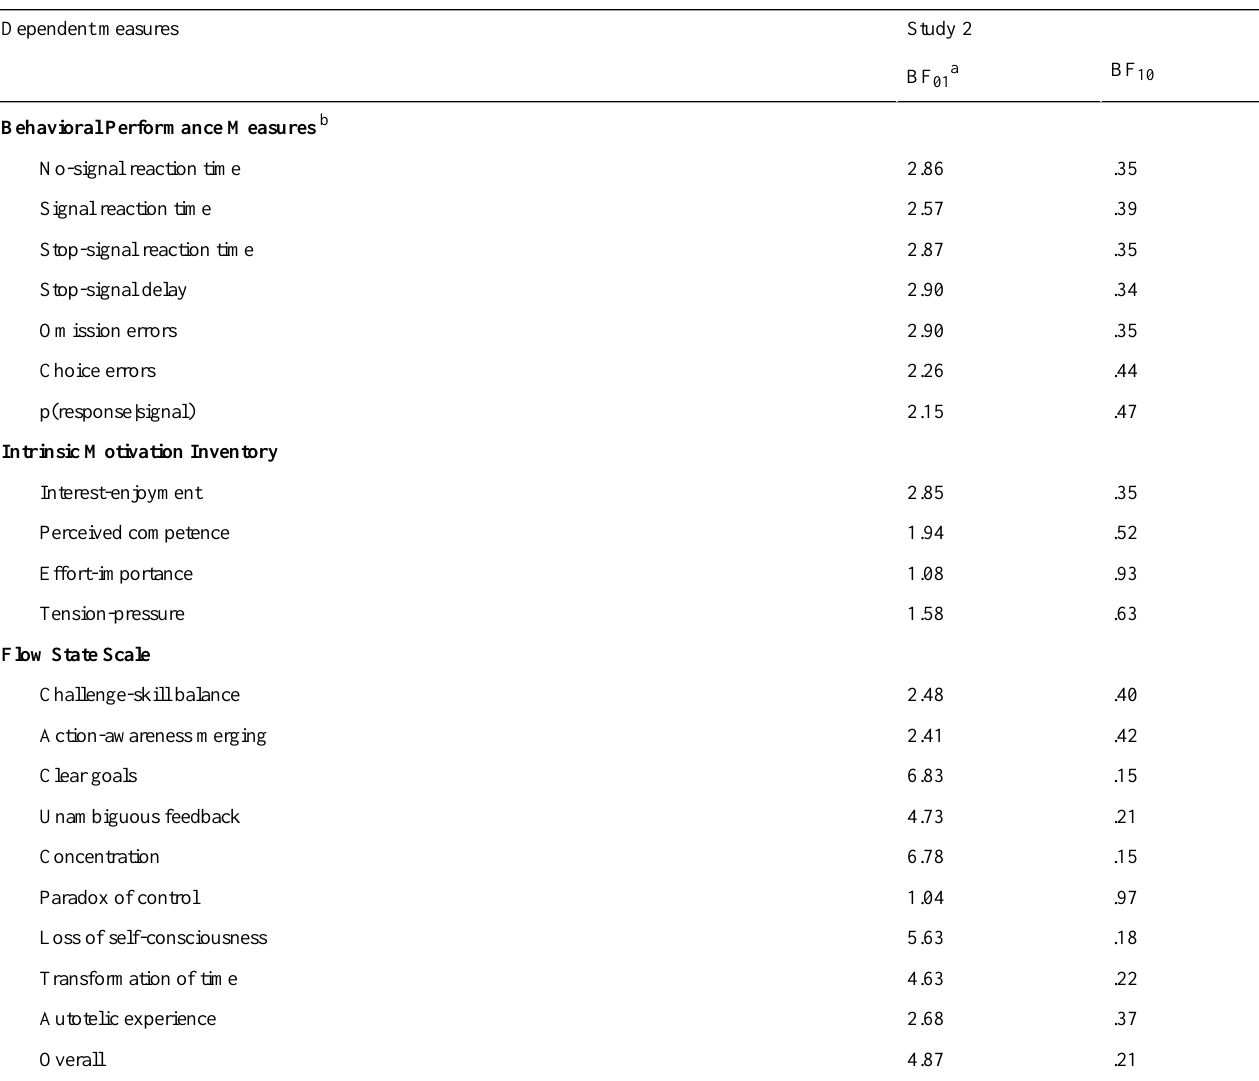
Table 10. The Bayes factor (BF) table showing BF01 and